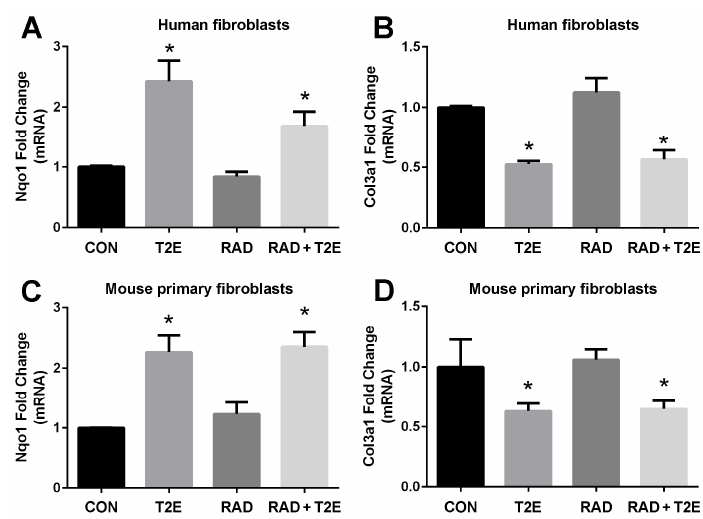
Figure 2. MnTE-2-PyP enhances NQO1 mRNA expression and reduces COL3A1 mRNA expression in human and mouse fibroblasts. ( A ). NQO1 mRNA in human P3158 fibroblasts, which are an immortalized human fibroblast cell line. ( B ). COL3A1 mRNA in human P3158 fibroblasts. ( C ). NQO1 mRNA in primary mouse fibroblasts. ( D ). COL3A1 mRNA in primary mouse fibroblasts. Differences in mRNA expression were analyzed using a 1-way ANOVA followed by a post hoc Tukey’s test for multiple comparisons. The symbol (*) denotes a significant difference as compared to the control group. These data were obtained from 4 independent experiments.